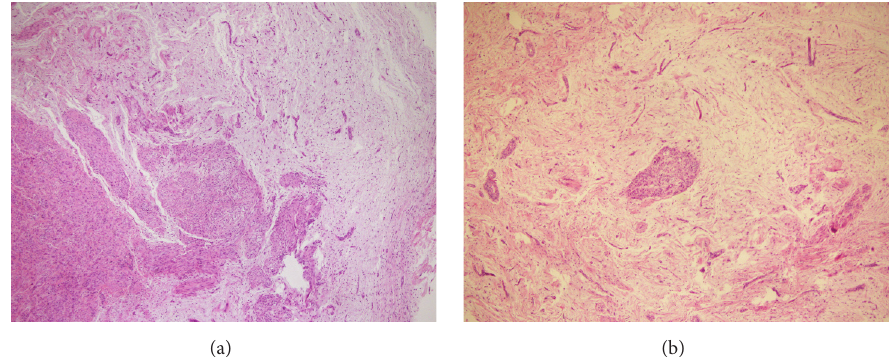
Figure 1: Histopathological findings. Plexiform proliferation of tumor cells with micronodules set in a myxoid background (hematoxylin and eosin stain; × 40 magnification).